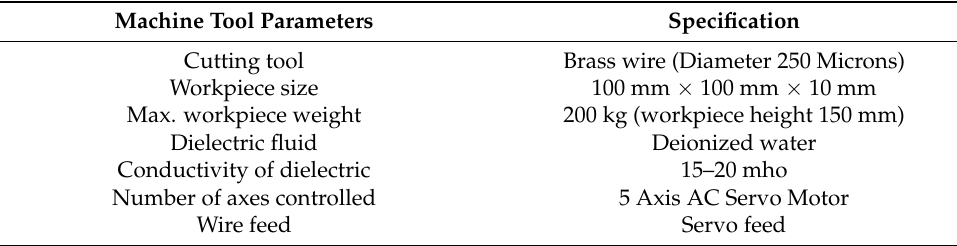
Table 4. Specification of WEDM machine tool parameters.